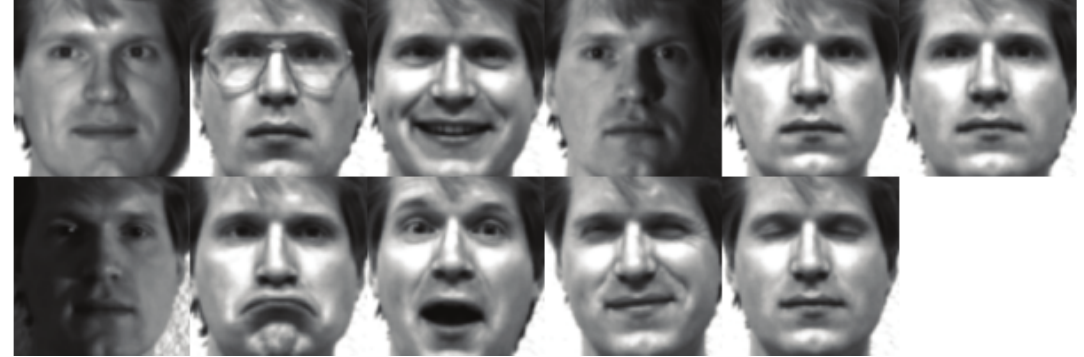
Figure 3: Images of one person from the Yale face database.